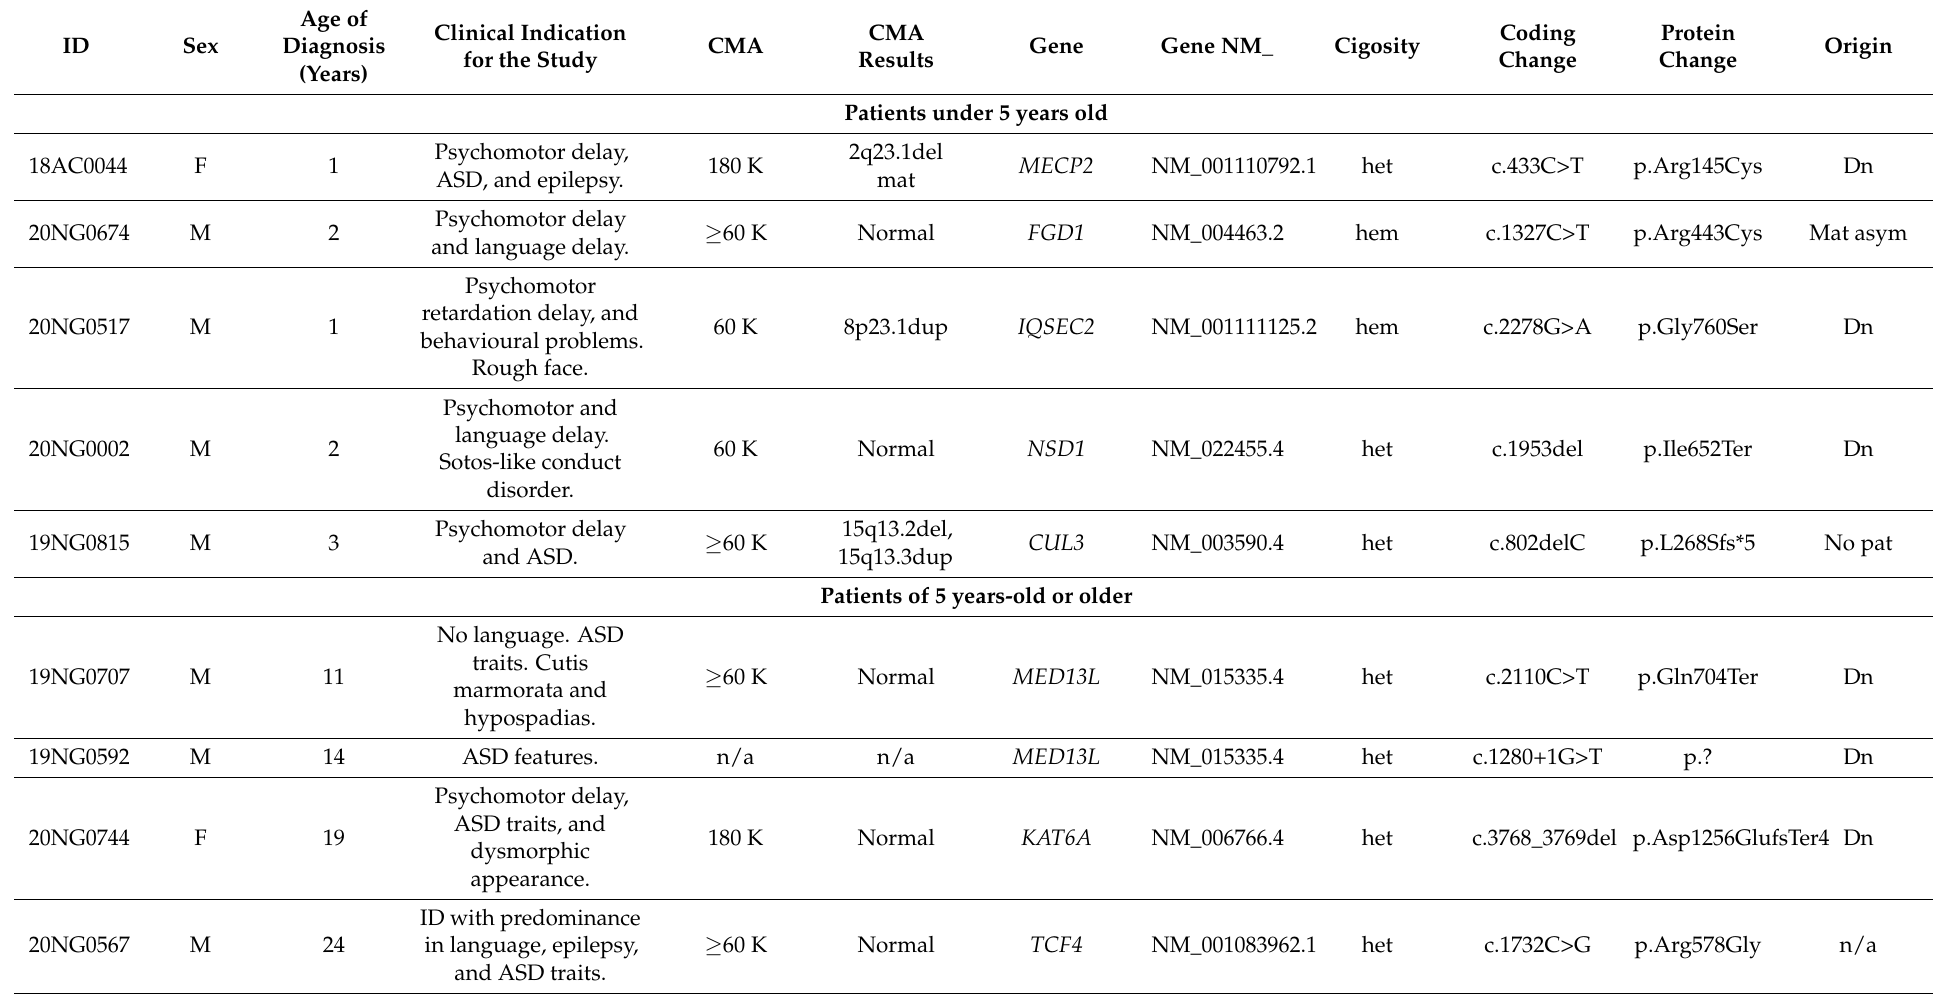
Table 4. Characteristics of ASD cases identified by